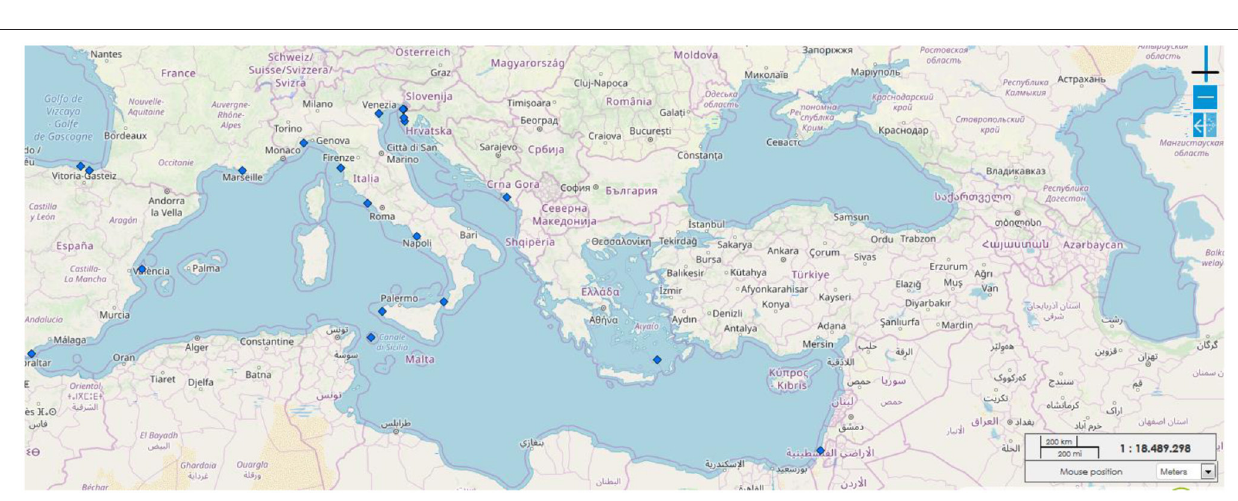
FIGURE 2 | Pilot projects in the MED area, (Maestrale WEBGIS,